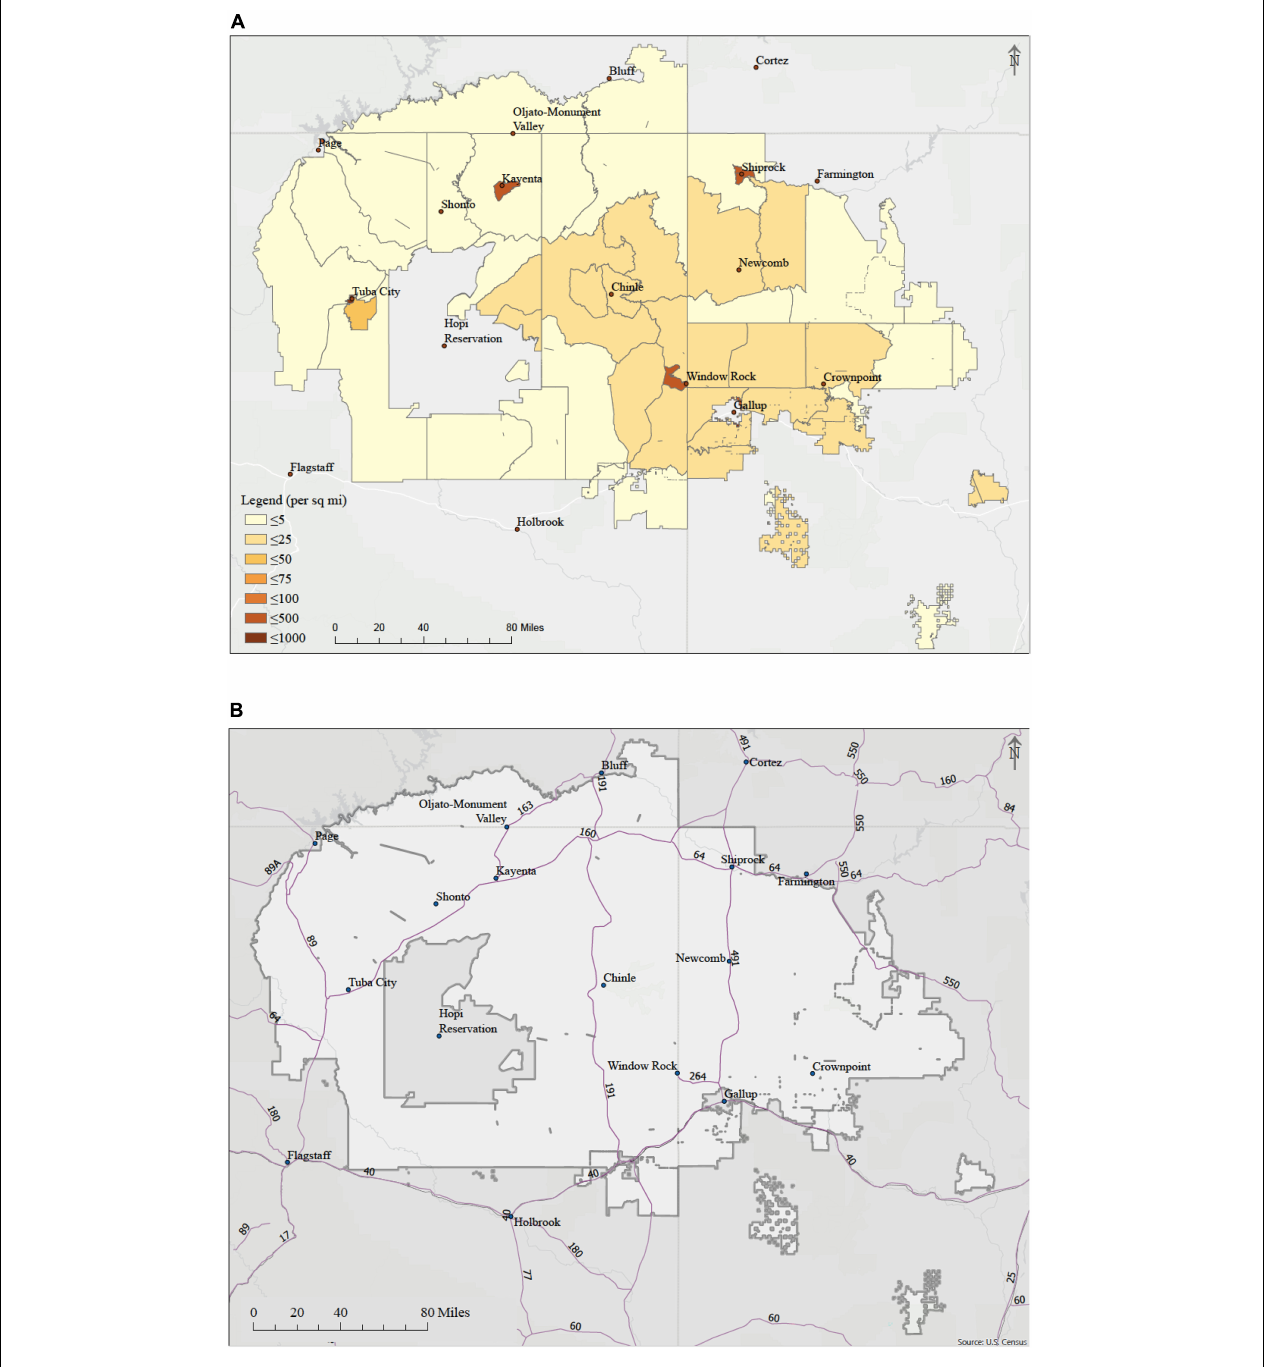
FIGURE 1 | Description of the Navajo reservation. (A) Population density in the Navajo reservation by census tract, as persons per square mile. (B) Major road networks into and on the reservation.